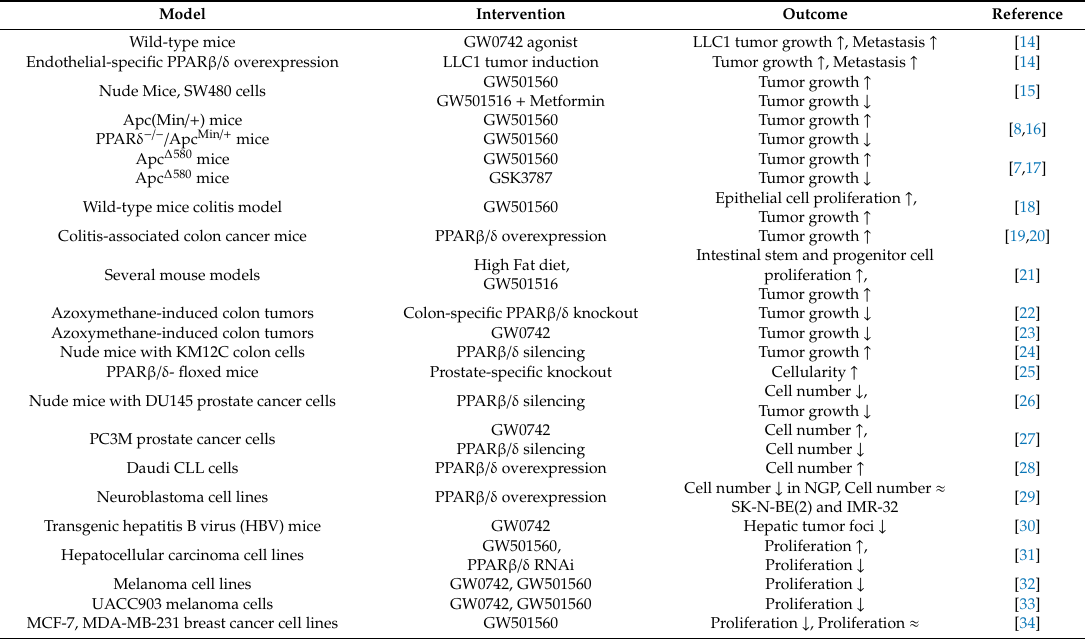
Table 1. E ff ects of PPAR β / δ on cell proliferation and tumor